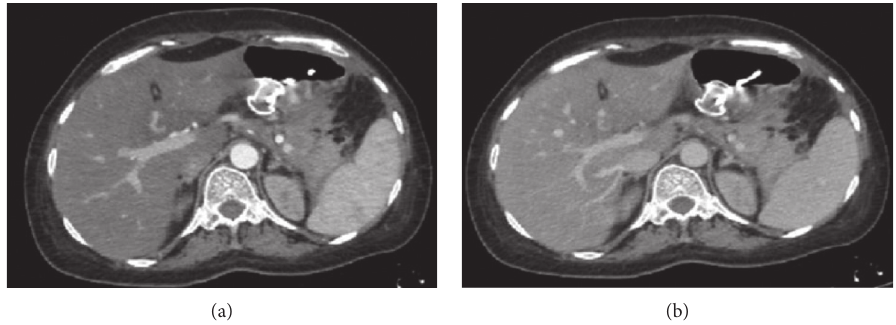
Figure 8: Contrast-enhanced CT scan reveals effective drainage of the pseudocyst.